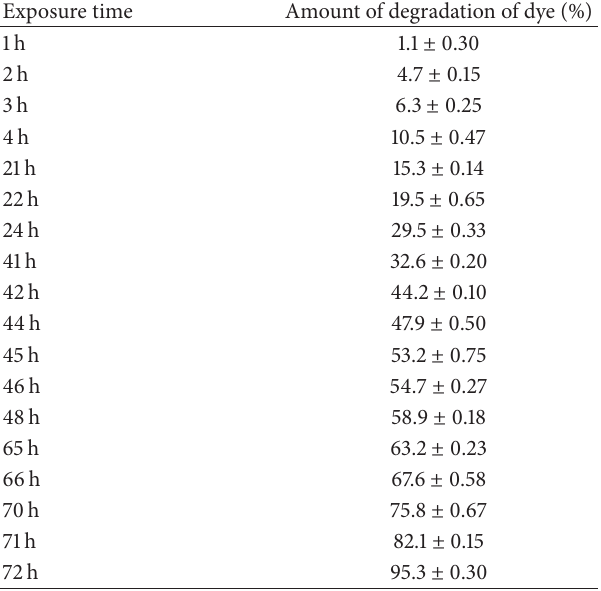
Table 1: Methylene blue degradation (%) by synthesized silver nanopartilces (10mg) analyzed by triplicate